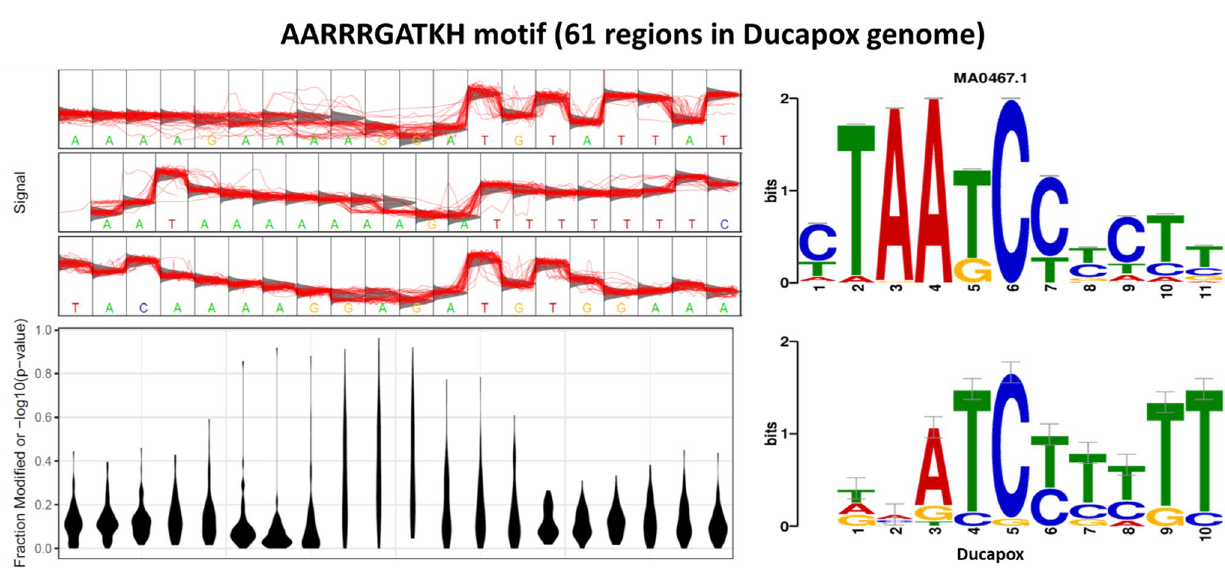
Figure 5. Statistical plot and sequence logo of the AAR RRG ATKH motif. The statistical plot is based on 42 regions within the genome that contain the motif sequence. Signal fluctuation away from the canonical model can be seen around the central GA